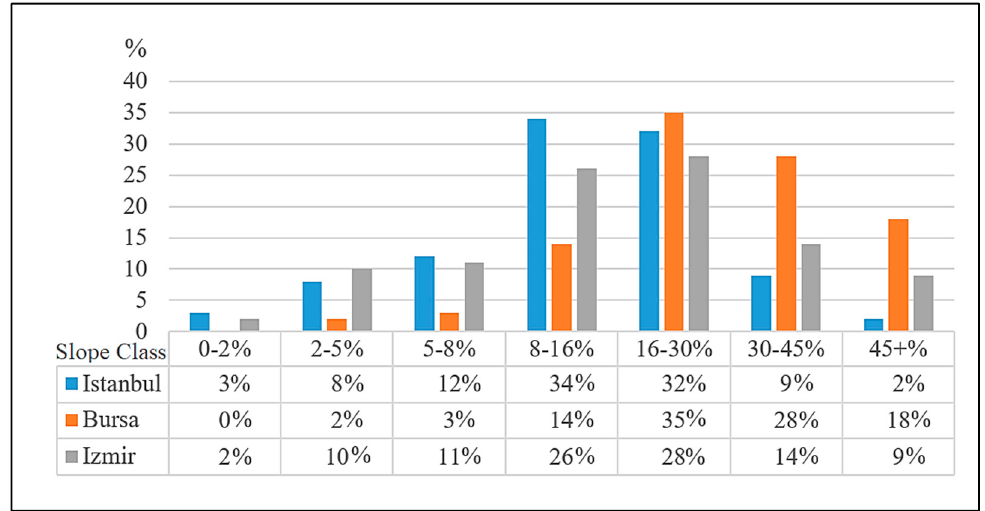
Figure 2. Topographic characteristics of the study regions.